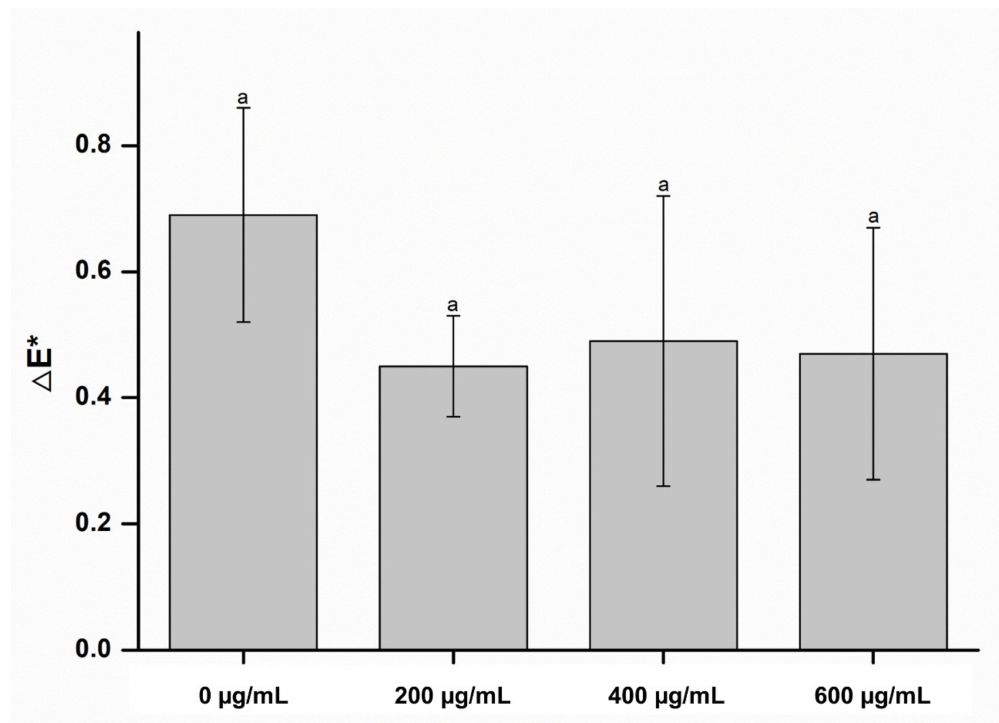
Figure 1. Color change in the experimental and control groups. Each value represents the mean of five measurements, and the error bar shows the standard deviation of the mean value. The lowercase letter indicates that there were no significant differences between the values of the experimental and control groups ( p > 0.05).